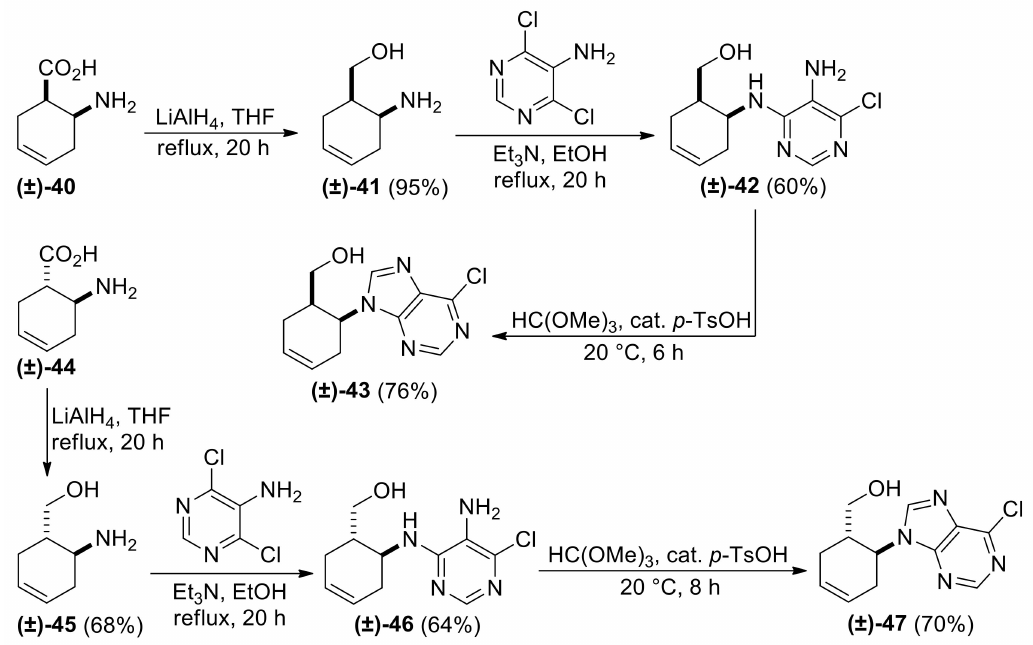
Scheme 9. Synthesis of unsaturated carbanucleoside isomers ( ± )-43 and ( ± )-47 analogs of carbocyclic nucleoside ( ±